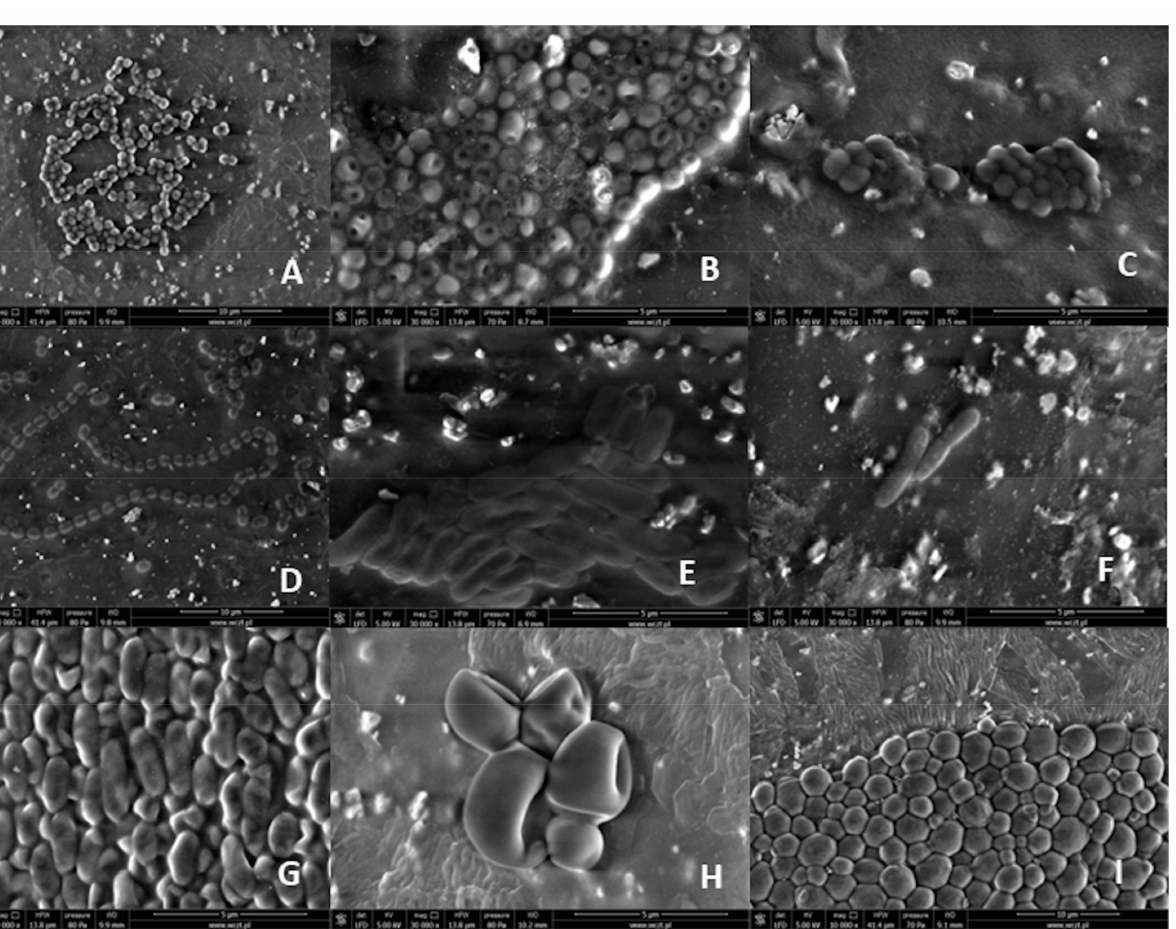
Figure 1. Scanning electron microscopy (SEM) images of reference pathogens: Gram-positive cocci: ( A ) Staphylococcus aureus , ( B ) Staphylococcus epidermidis ; Gram-positive cocci—streptococci: ( C ) Strep- tococcus parasanguinis ; Gram-positive enterococci: ( D ) Enterococcus fecalis ; Gram-negative bacilli ( E ) Klebsiella pneumonie , ( F ) Escherichia coli , ( G ) Pseudomonas aeruginosa ; yeast-like fungi of the Candida genus: ( H ) Candida dubliniensis , ( I ) Candida albicans